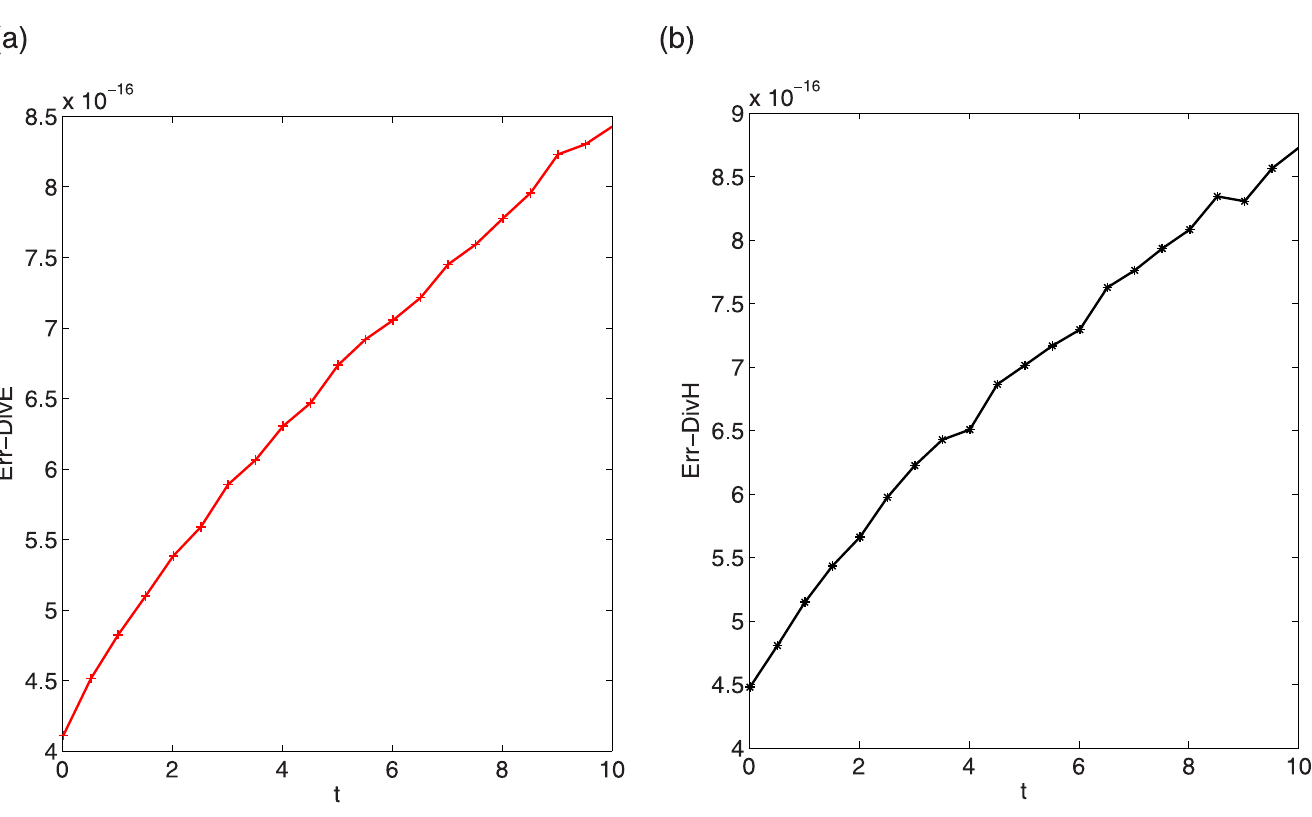
Fig 15. Divergence errors Err-DivE (left) and Err-DivH (right) in first testing case.